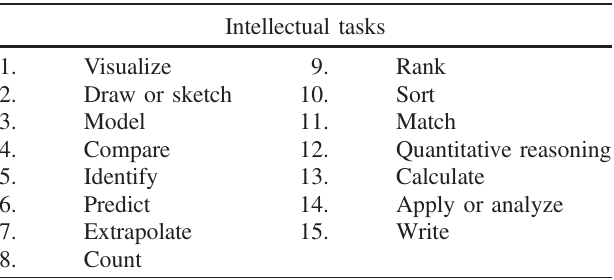
TABLE II. Intellectual tasks recognized in curricular materials.